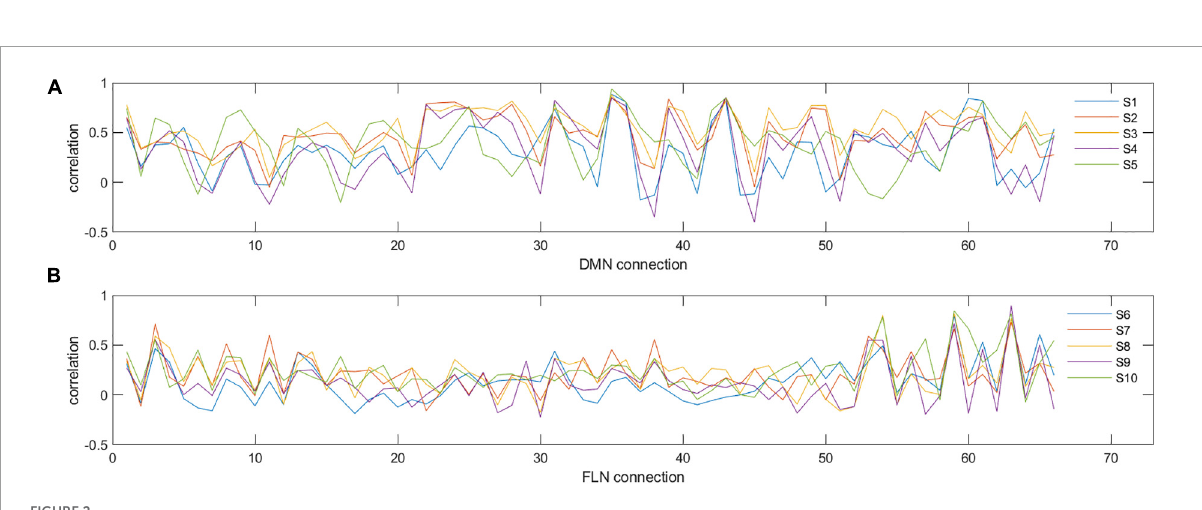
FIGURE2 Examples of individual connectivity ‘profiles’ in DMN (A) and FLN (B) for five selected participants (S1–S5 for DMN and S6–S10 for FLN). y -axis represents the correlation strength and x -axis represents each of the different pairwise correlations of all the nodes in that network. As can be seen, certain nodes show very consistent correlations across participants, while others show variability. For example, for the DMN, connectivity measure numbers 31, 35, and 36 are consistent across the five participants (reflecting similarity), whereas connectivity measure numbers 30, 32, 33, and 34 show high variability (reflecting